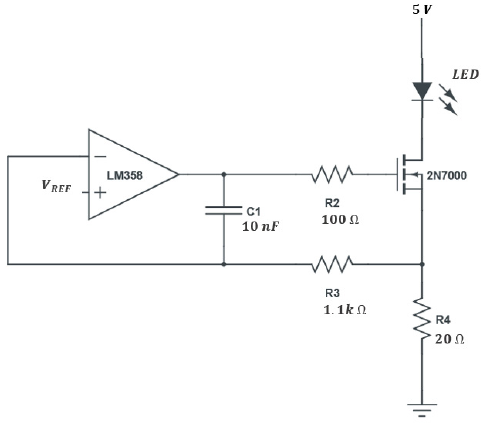
Figure 5. Constant current sink used to feed the excitation LED.